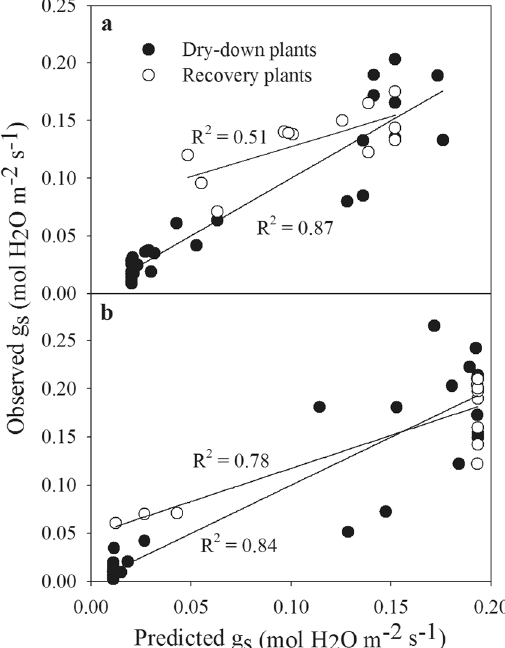
Figure 8. Relationship between predicted and observed g s in plants in the dry-down and recovery groups. There was a significant difference in the slopes between the recovery and dry-down datasets. All of the plants showed a strong correlation (r 2 ) between the observed and predicted g s (P < 0.05).